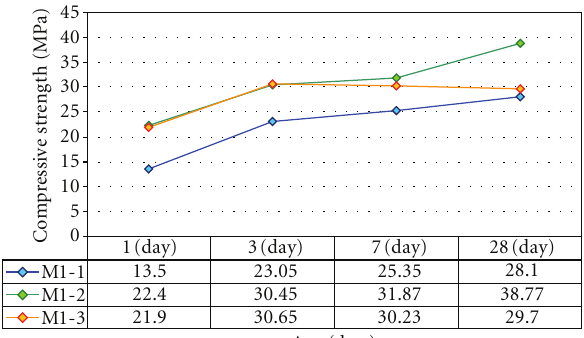
Figure 7: Compressive strength of the 1st